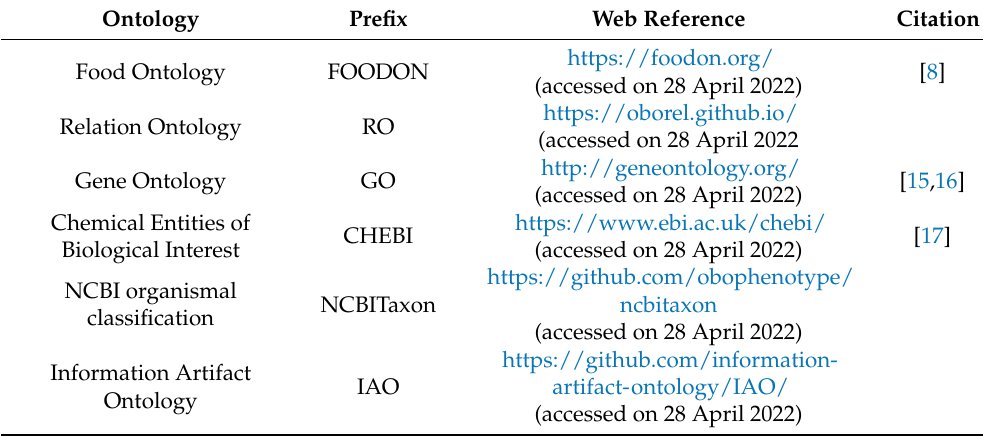
Table 1. Reuse of terms from pre-existing external ontologies, imported in ONS for completing the modeling in this